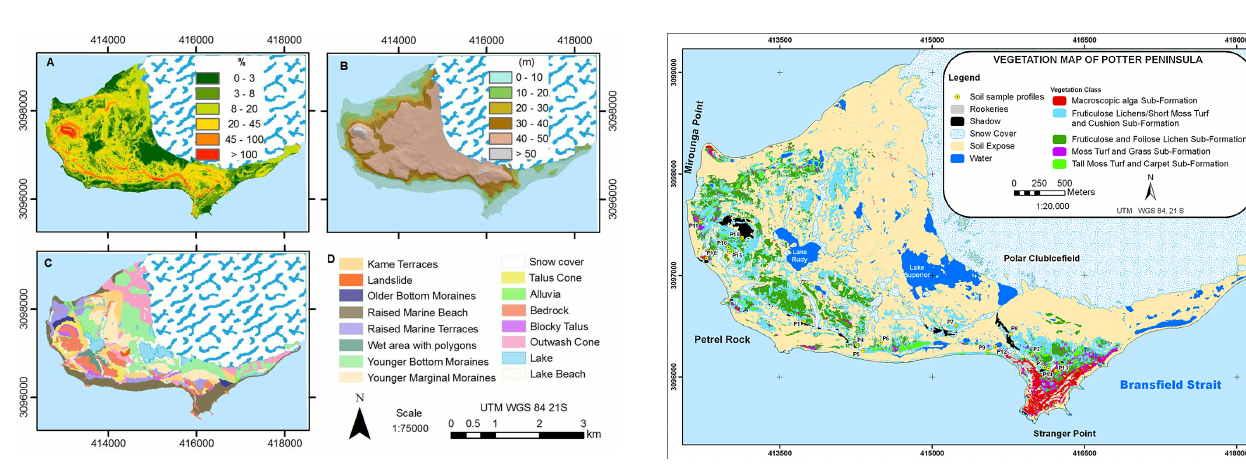
Figure 2. Map of hypsometry (a) , altimetry (b) and geomorphology (Birkenmajer, 1988) (c) . Legend is shown in (d) (Poelking, 2011).